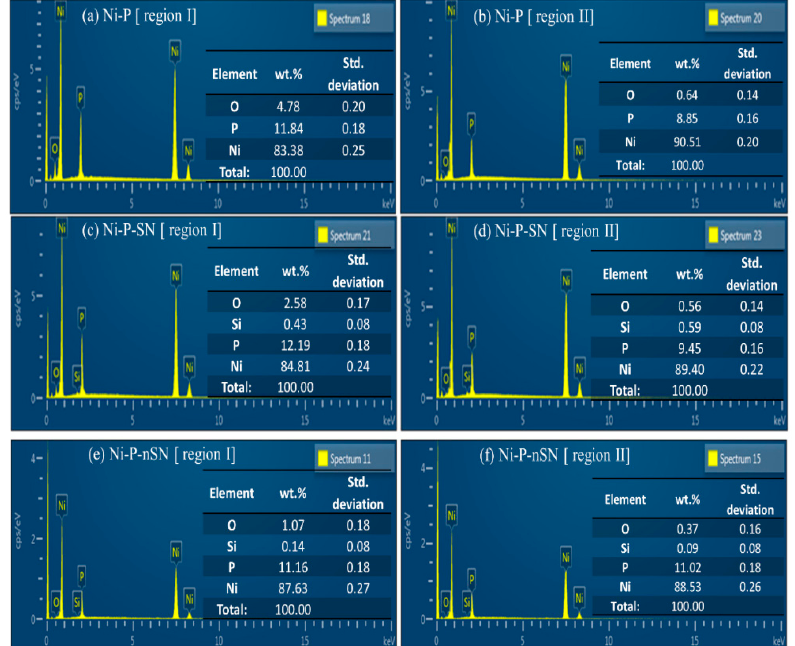
Figure 15. EDS findings of the deteriorated substrate ( region I ) and original substrate ( region II ) of ( a , b ) Ni-P, ( c , d ) Ni-P-SN, and ( e , f ) Ni-P-nSN samples. Reprinted with permission from Ref. [85]. MDPI (2022).